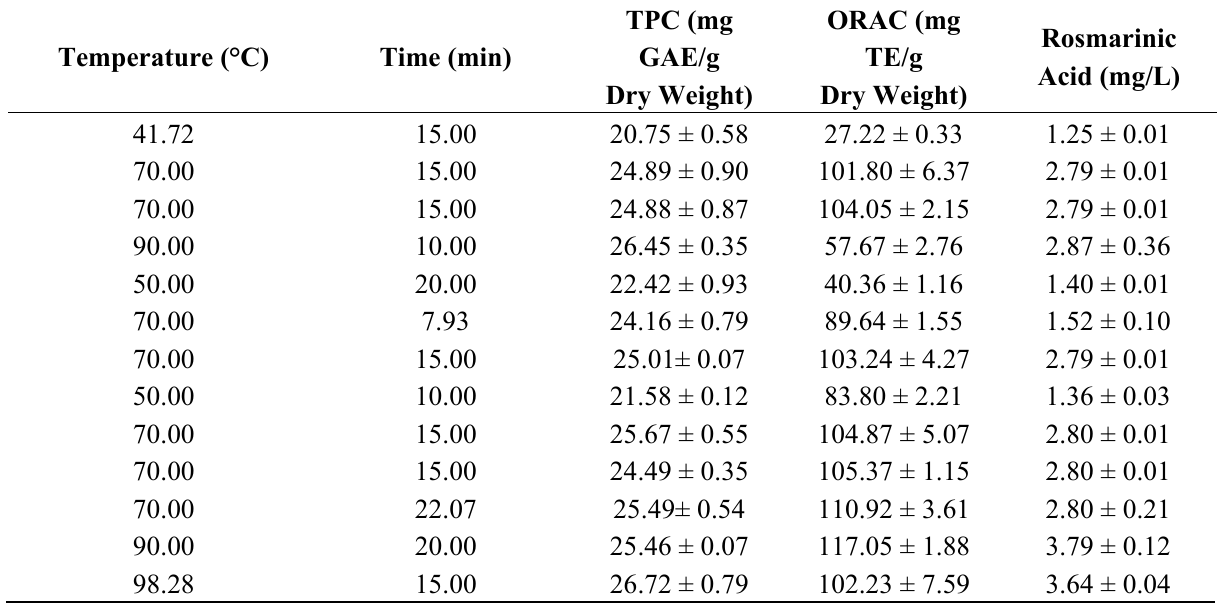
Table 2. Experimental design and responses for aqueous